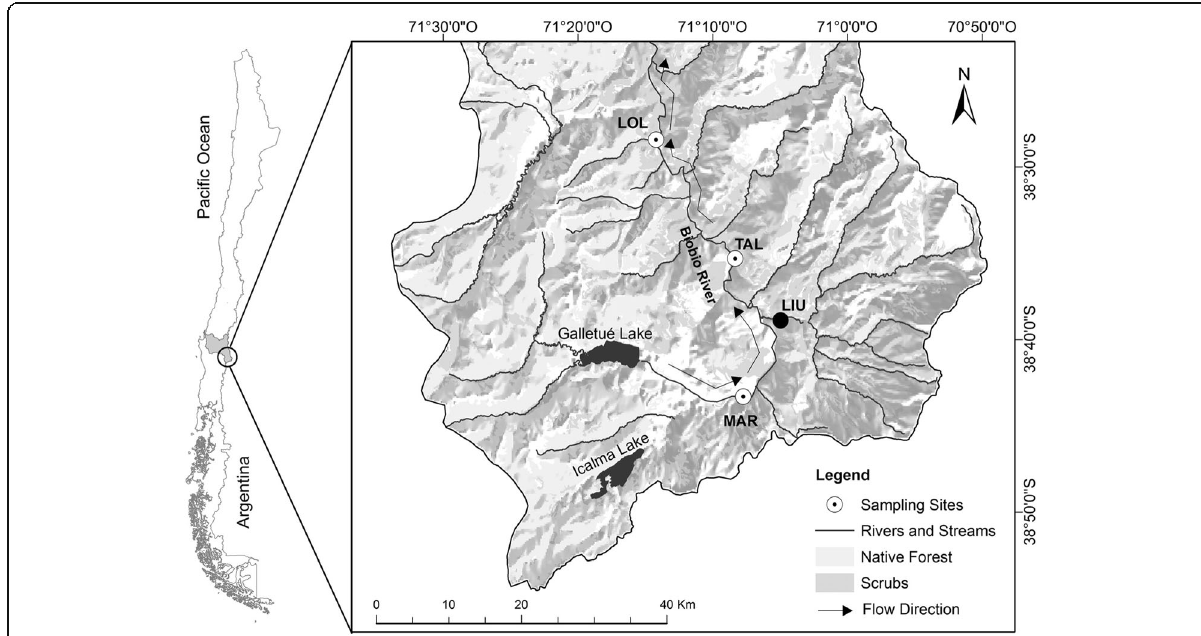
Fig. 1 Map of Andean section of the Biobio river basin (Chile). White circles indicate sites invaded by D. geminata and the black circle the site that was not invaded. The arrows indicate the flow